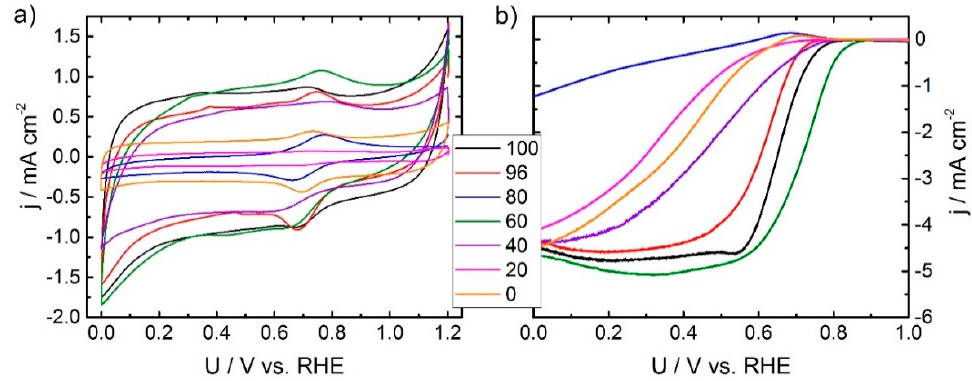
Figure 2. Cyclic voltammetry (100 mV s − 1 ) in N 2 saturated 0.1 M H 2 SO 4 ( a ) and rotating disc electrode experiments (rpm 1500, 10 mV s − 1 ) ( b ) of the variation series.